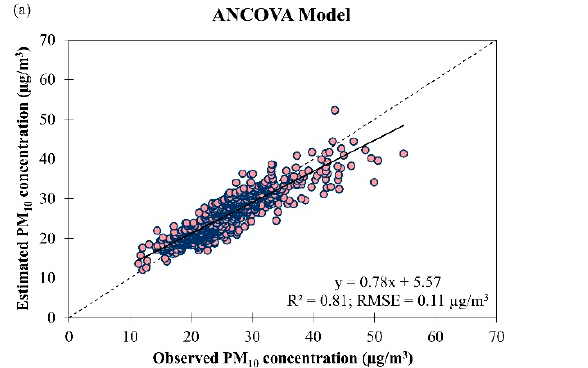
Figure 10. Scatter plots of estimated daily PM 10 concentration against observed daily PM 10 concen- tration by ( a ) ANCOVA and ( b ) RFR models for overall air quality in Singapore from March 2016 to February 2018.